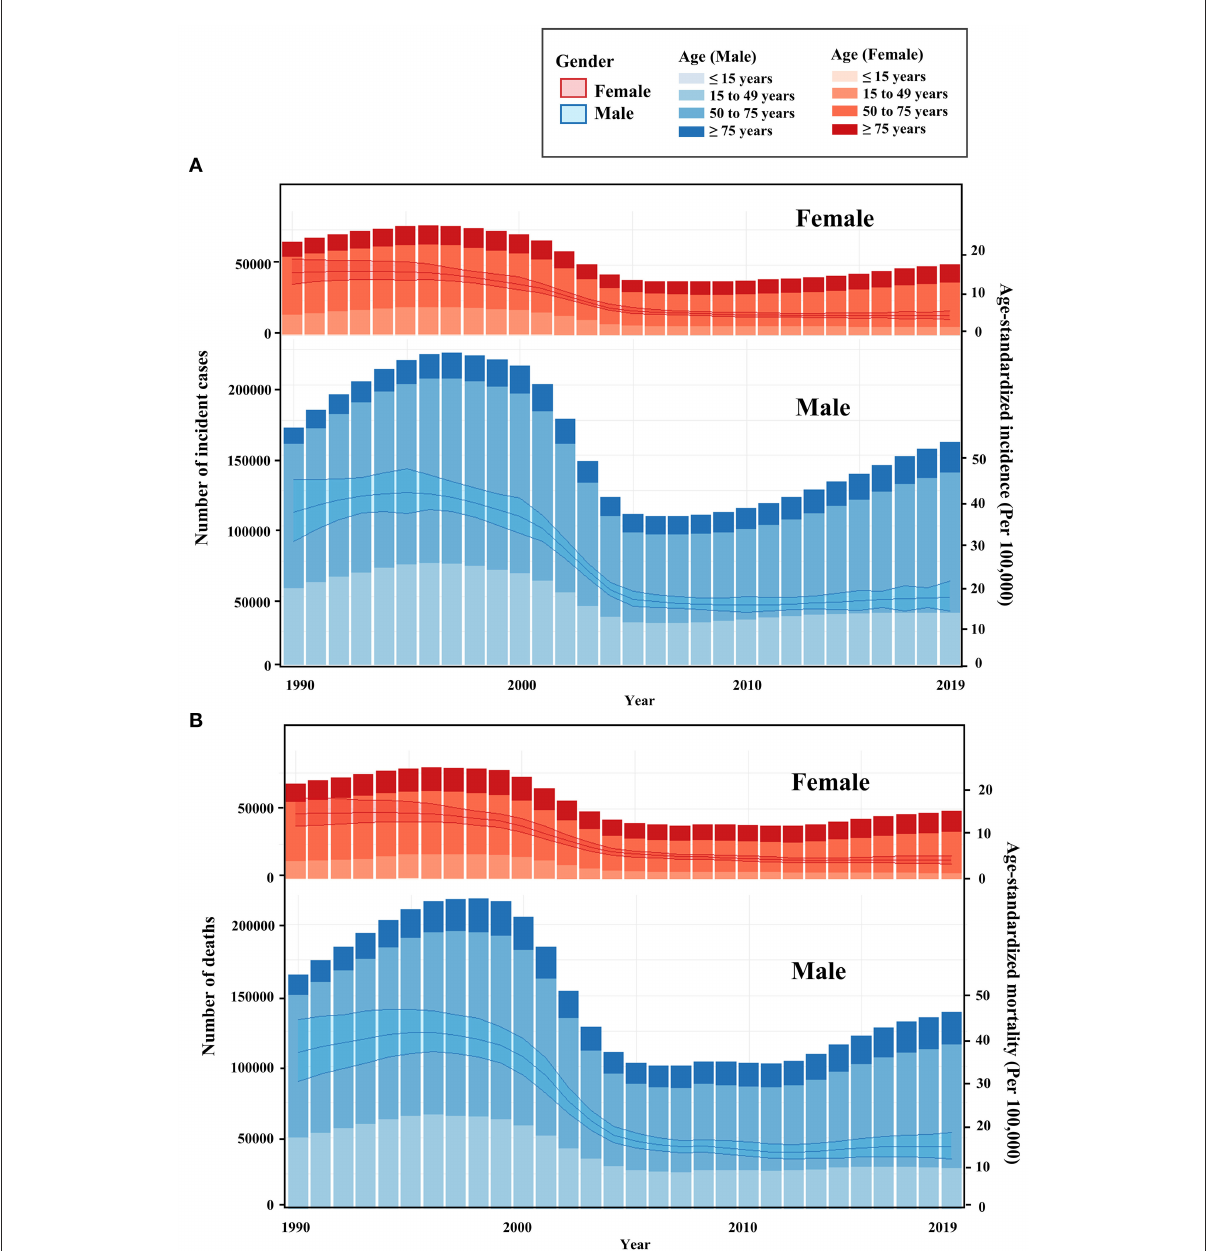
FIGURE1 Temporal trend of liver cancer in China. (A) Temporal trend of age-standardized incidence and number of cases for liver cancer from 1990 to 2019 in China; (B) Temporal trend of age-standardized mortality and number of deaths for liver cancer from 1990 to 2019 in China. The bar was the number of liver cancer cases and liver cancer-associated deaths from 1990 to 2019. The line with 95% UI represents incidence and mortality from 1990 to 2019.